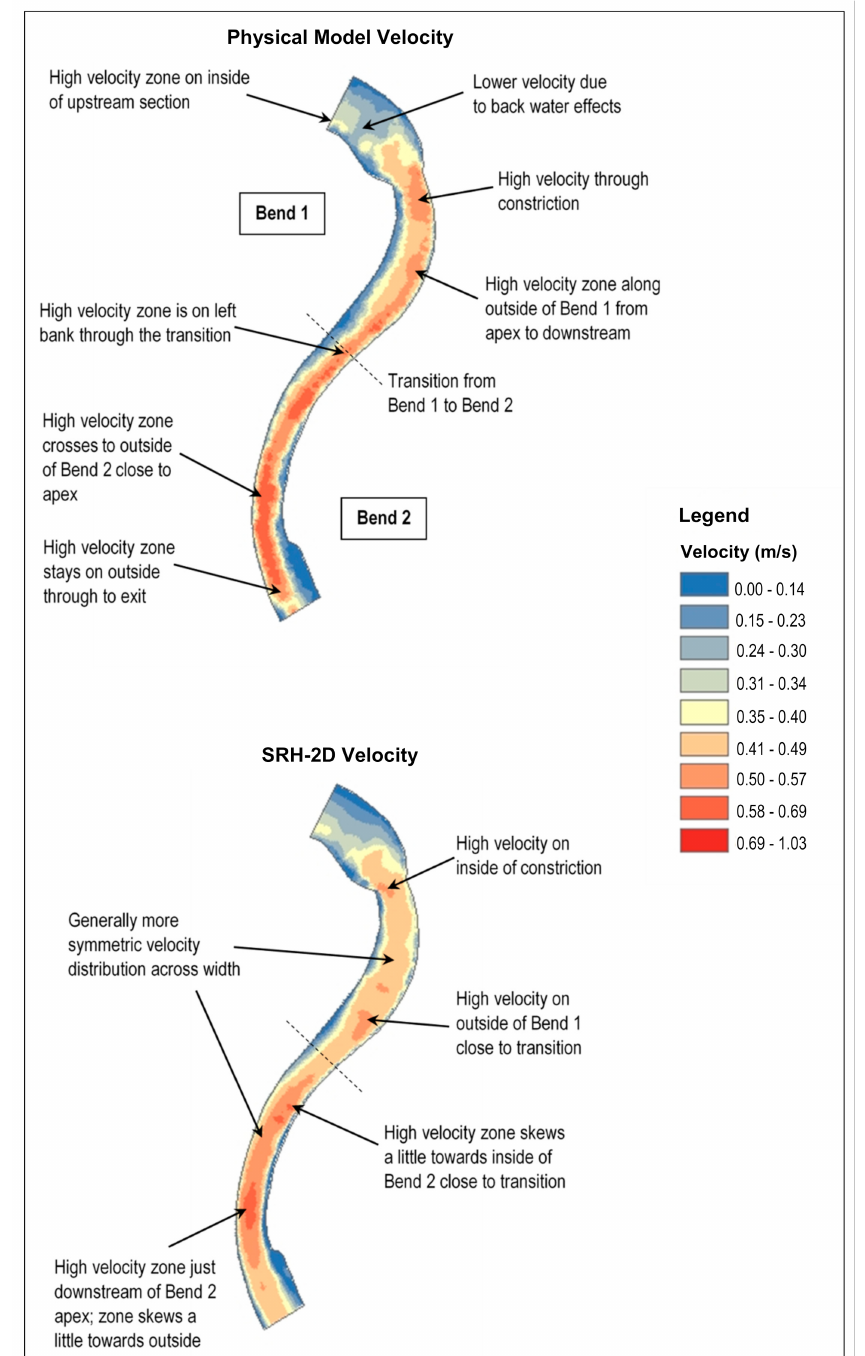
Figure 16. Baseline configuration comparison of physical model-measured and SRH-2D-predicted depth-averaged velocity